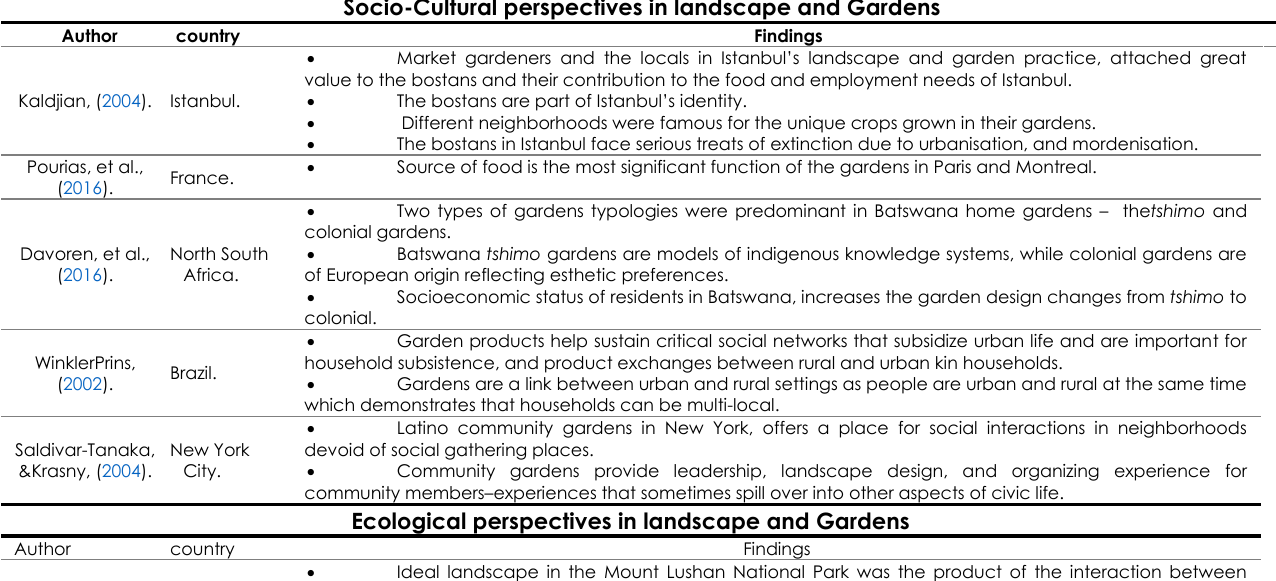
Table 1. Summary of the literature review and findings from selected studies on the socio-cultural and ecological perspectives in landscape and